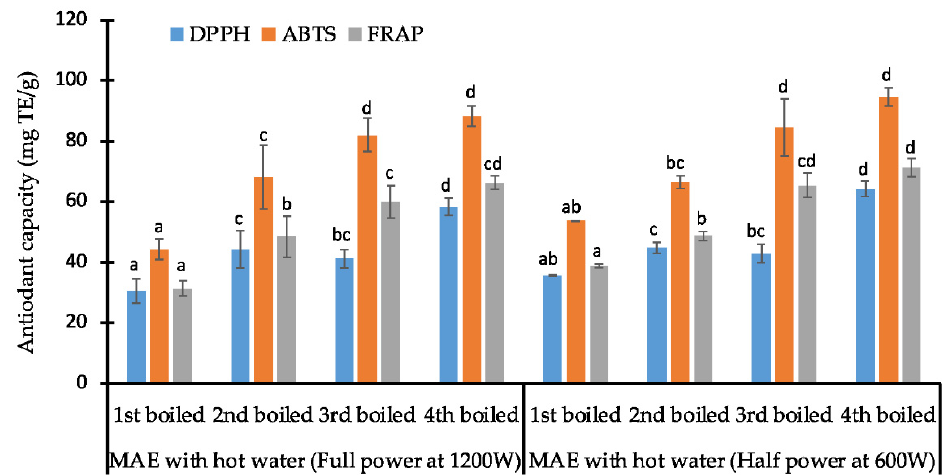
Figure 5. Antioxidant activity of herbal tea infusion prepared at different microwave assisted conditions with hot water. Data are means ± standards deviations. Data for each antioxidant assay (DPPH, ABTS, or FRAP) not sharing similar letters are significantly different at p < 0.05.